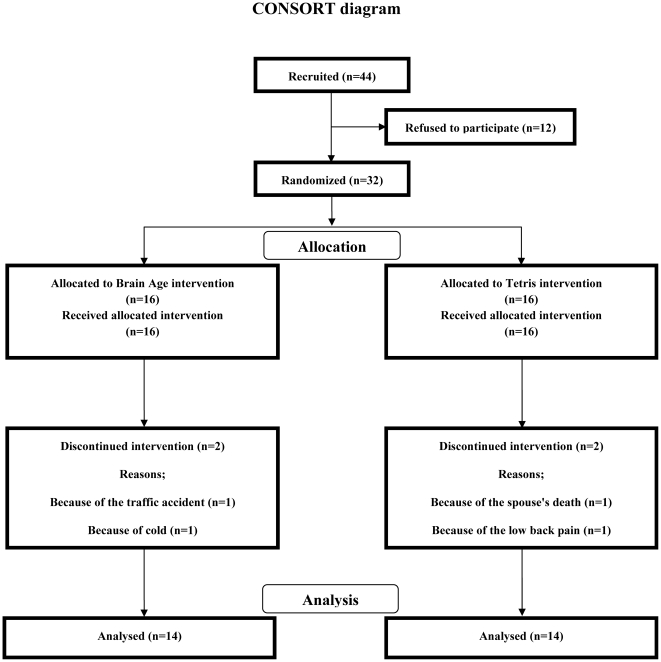
CONSORT flowchart.